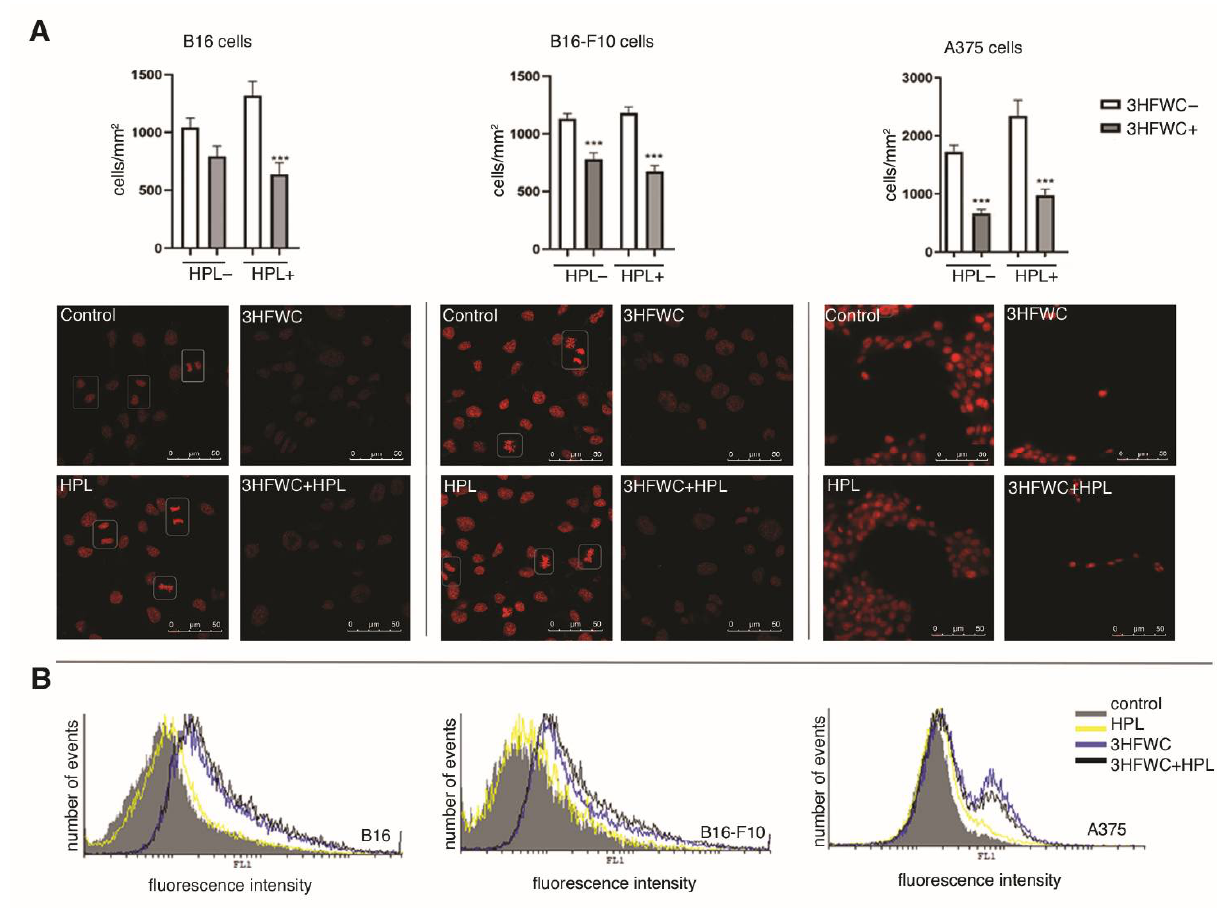
Figure 2. Inhibition of melanoma cell proliferation by 3HFWC and/or HPL in vitro. ( A ) Cell abun- dance (cells/mm 2 ) and propidium iodide staining (white squares—mitotic figures; magnification: ×630, scale bar: 50 µm); ( B ) carboxyfluorescein succinimidyl ester (CFSE) staining; *** significant if p < 0.001 in comparison to untreated (control) cells.